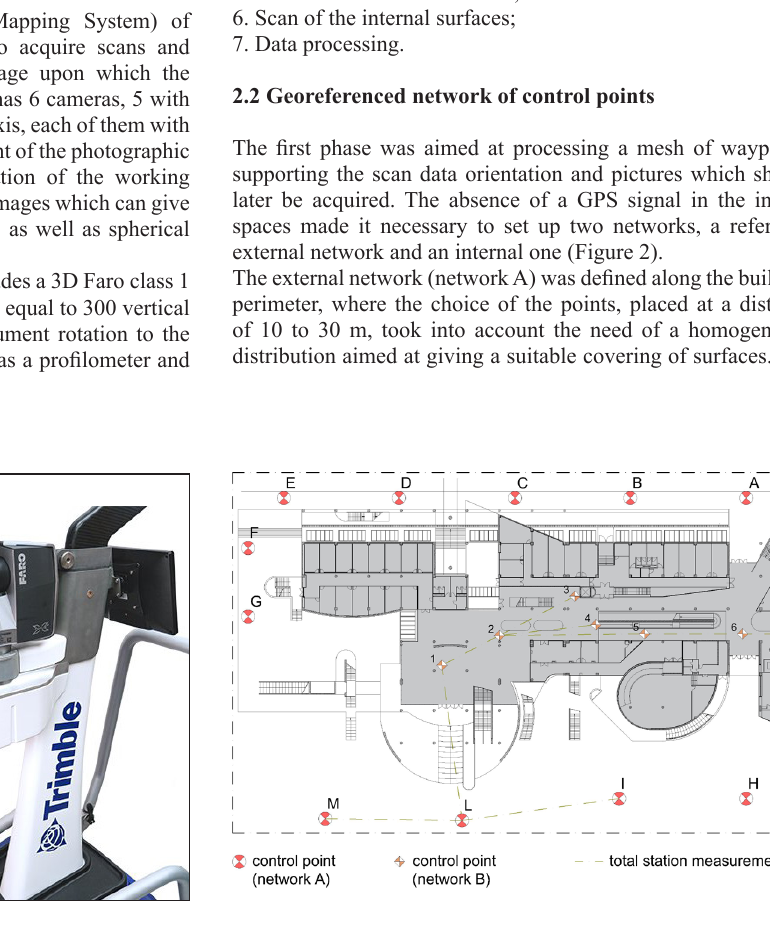
Figure 1. TIMMS (Trimble Indoor Mobile Mapping System) Figure 2. Network control